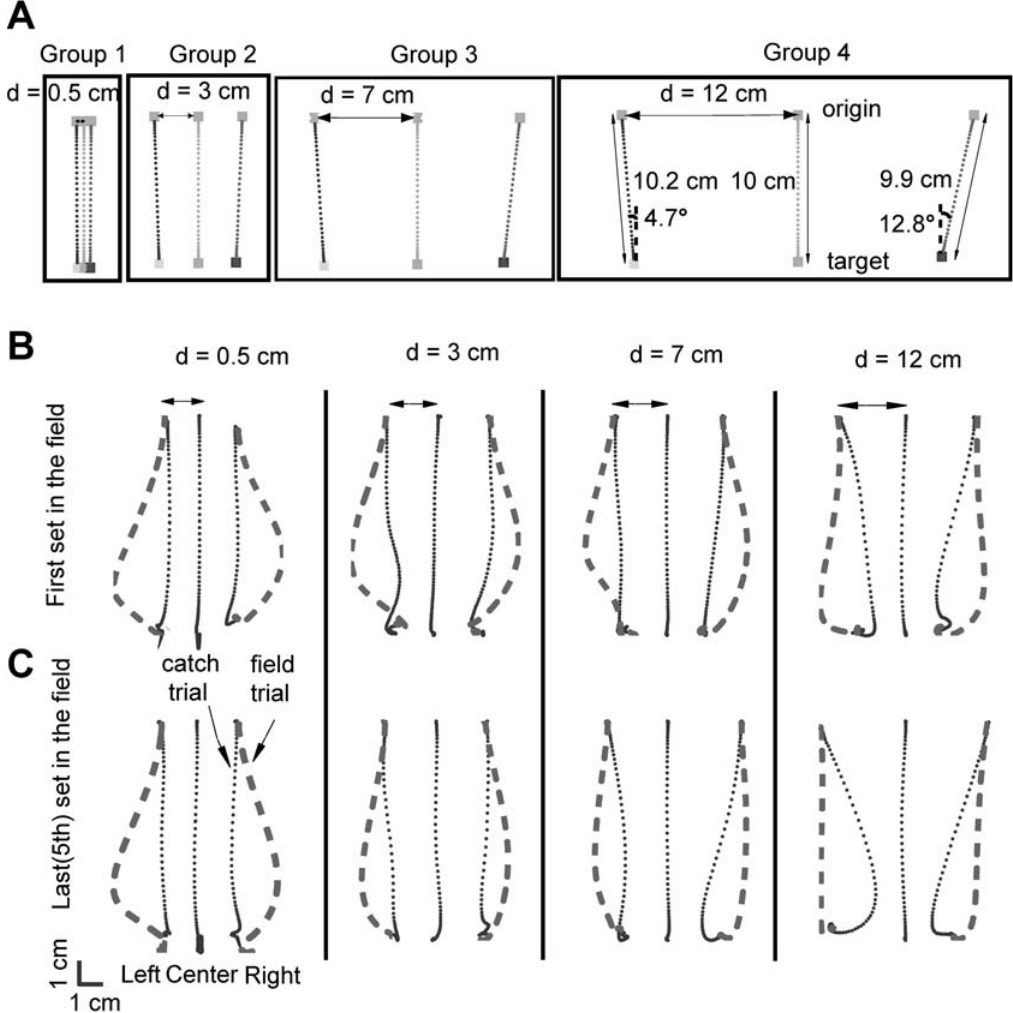
Figure 1. Adaptation to a Force Field That Depends on Both Position and Velocity of the Limb (A) The origin of the center movements is aligned with the subject’s body midline, and the origins of the left and right movements are symmetrically positioned with a given separation distance ( d ) for each group. The target positions shown here are an example for a subject with typical arm lengths (20, 33, 34 cm shoulder, upper arm, and lower arm lengths, respectively). In order to help subjects distinguish among locations, different colors were provided for targets at different locations (yellow, green, and blue for the left, center, and right, respectively). (B) The average trajectories in three positions—left, center, and right (one subject per column)—for the first third of the movements from the first field set (trials 1–28). Dashed lines are movements during which force field is on and dotted lines are catch trials. Separation distances between neighboring movements ( d ) are not scaled in this figure. (C) The average trajectories for the first third of the fifth field set (trials 337–364). The task is much easier to learn when the three movements are spatially separated from each other. DOI: